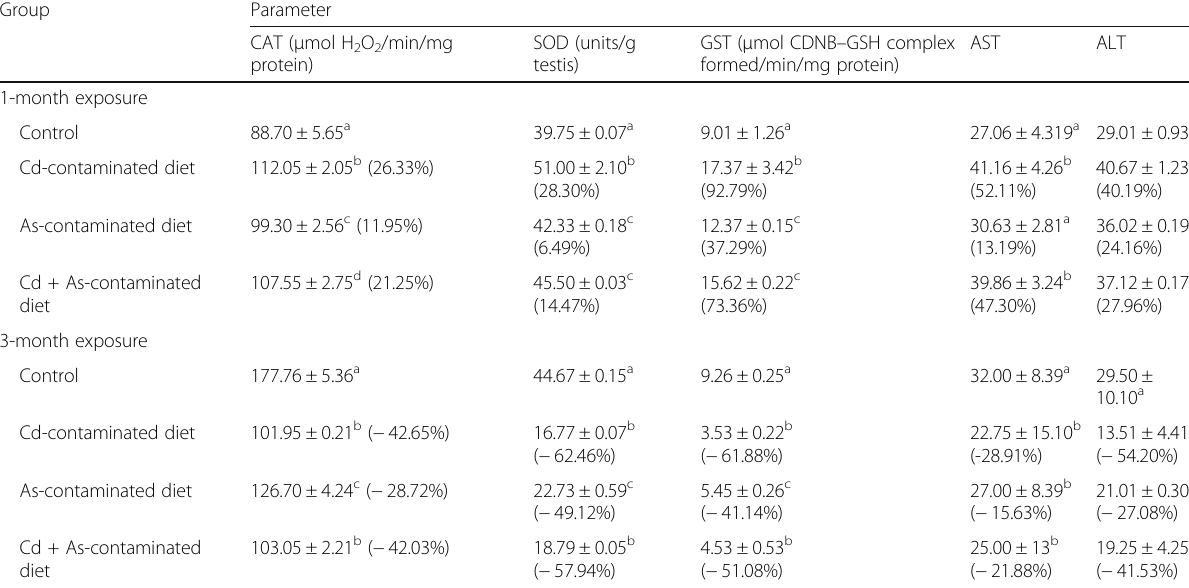
Table 5 Effect of treatment on enzymatic activities in the kidney of experimental rats